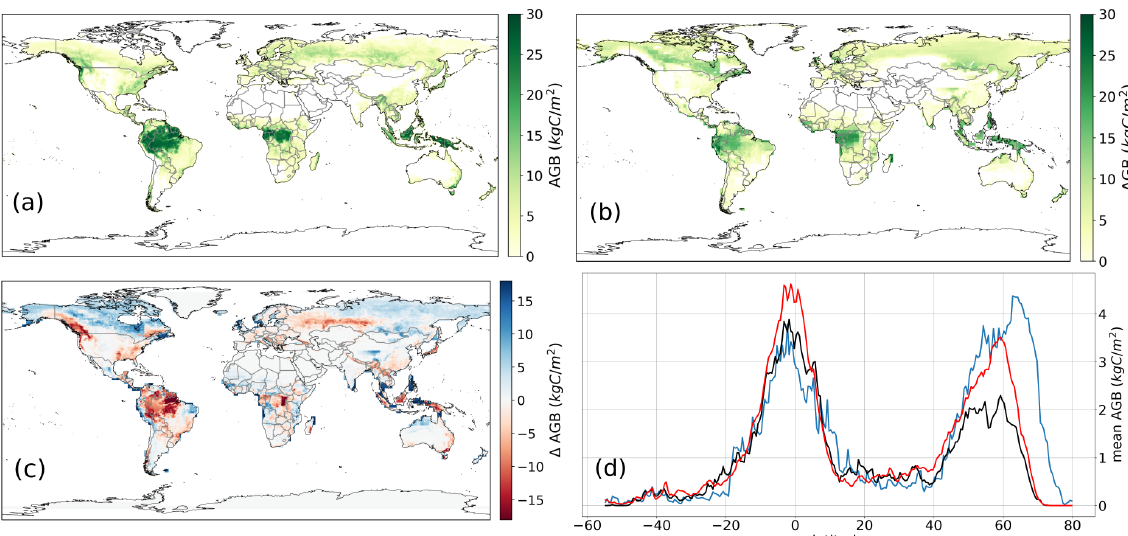
Figure 8. (a) Mean global aboveground biomass of GlobBiomass evaluation data. (b) Mean global aboveground biomass of CM2Mc- LPJmL (TR) over the 2006–2015 period. (c) Difference in the aboveground biomass between CM2Mc-LPJmL and GlobBiomass evaluation data. Blue (red) denotes an overestimation (underestimation) of biomass by CM2Mc-LPJmL. (d) Latitudinal sum of aboveground biomass from CM2Mc-LPJmL (blue line, R 2 = 0 . 64, NME = 0.56), stand-alone LPJmL5 (black line, R 2 = 0 . 94, NME = 0.35) input data and Glob- Biomass evaluation data (red line).